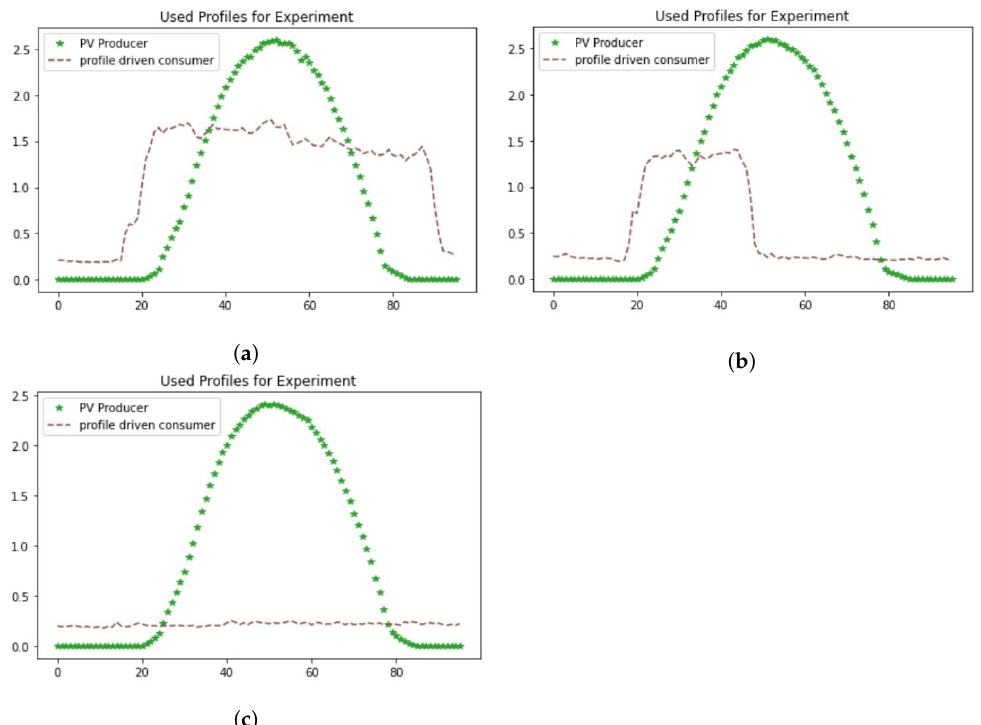
Figure 6. Energy profiles of the problem instances. ( a ) Day 1, ( b ) day 2, ( c) day